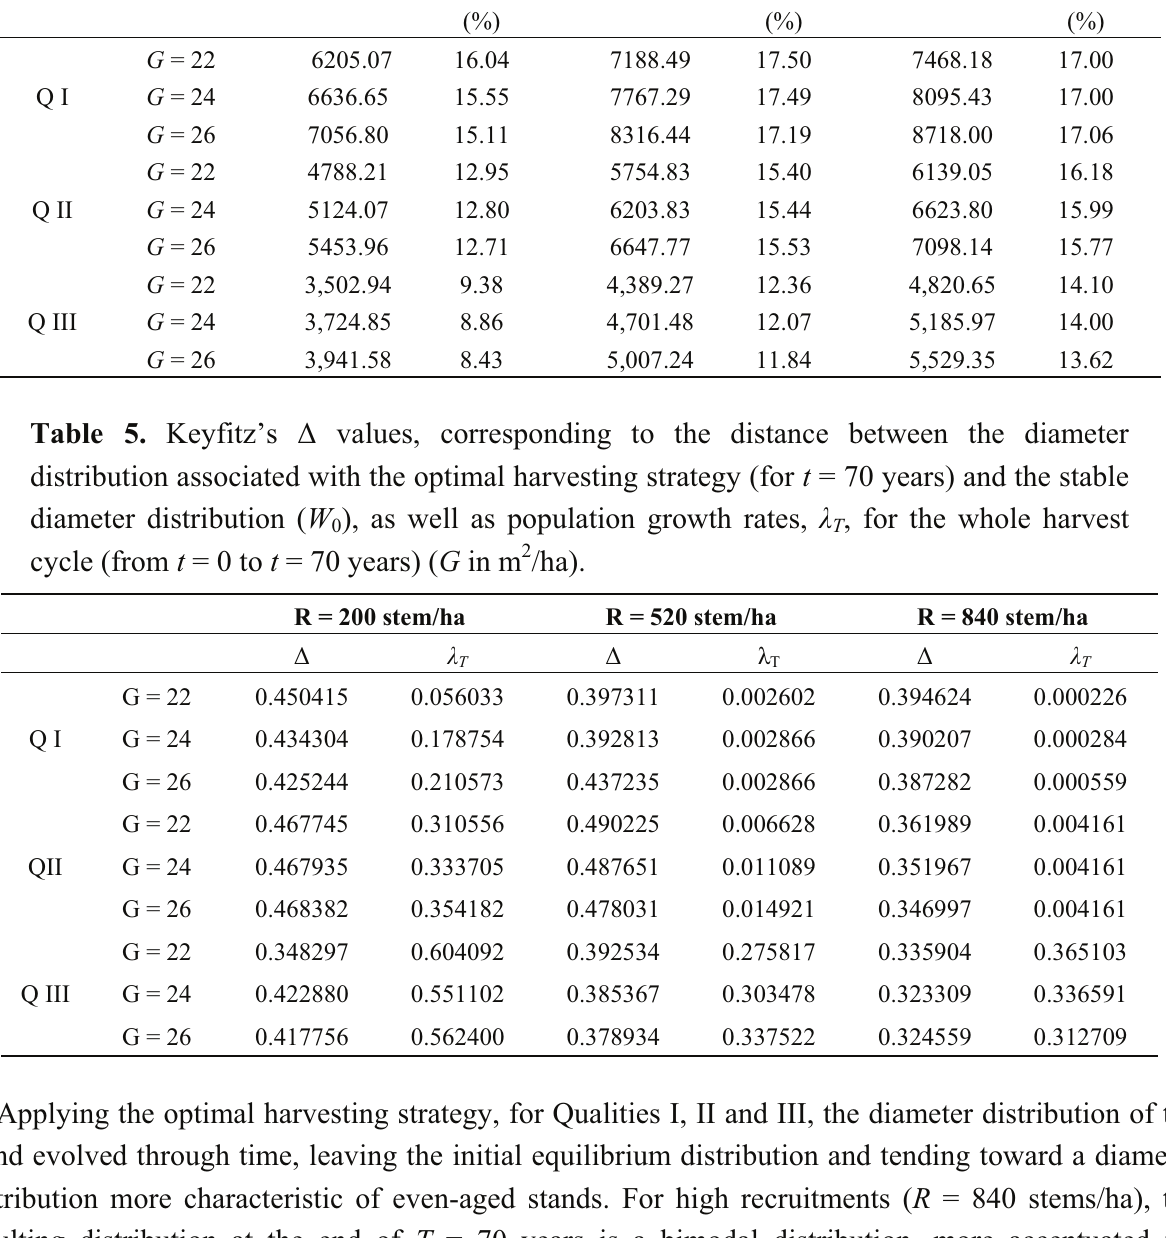
Table 4. Optimal strategy NPV and NPV increase (%) between the optimal and “sustainable/stable” harvesting strategies for i = 3% and different levels of Quality, R and G ( G in m 2 /ha).